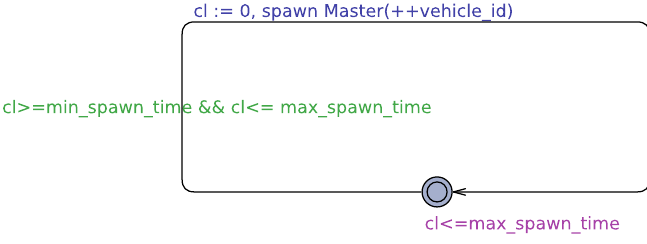
Figure 4. Traffic